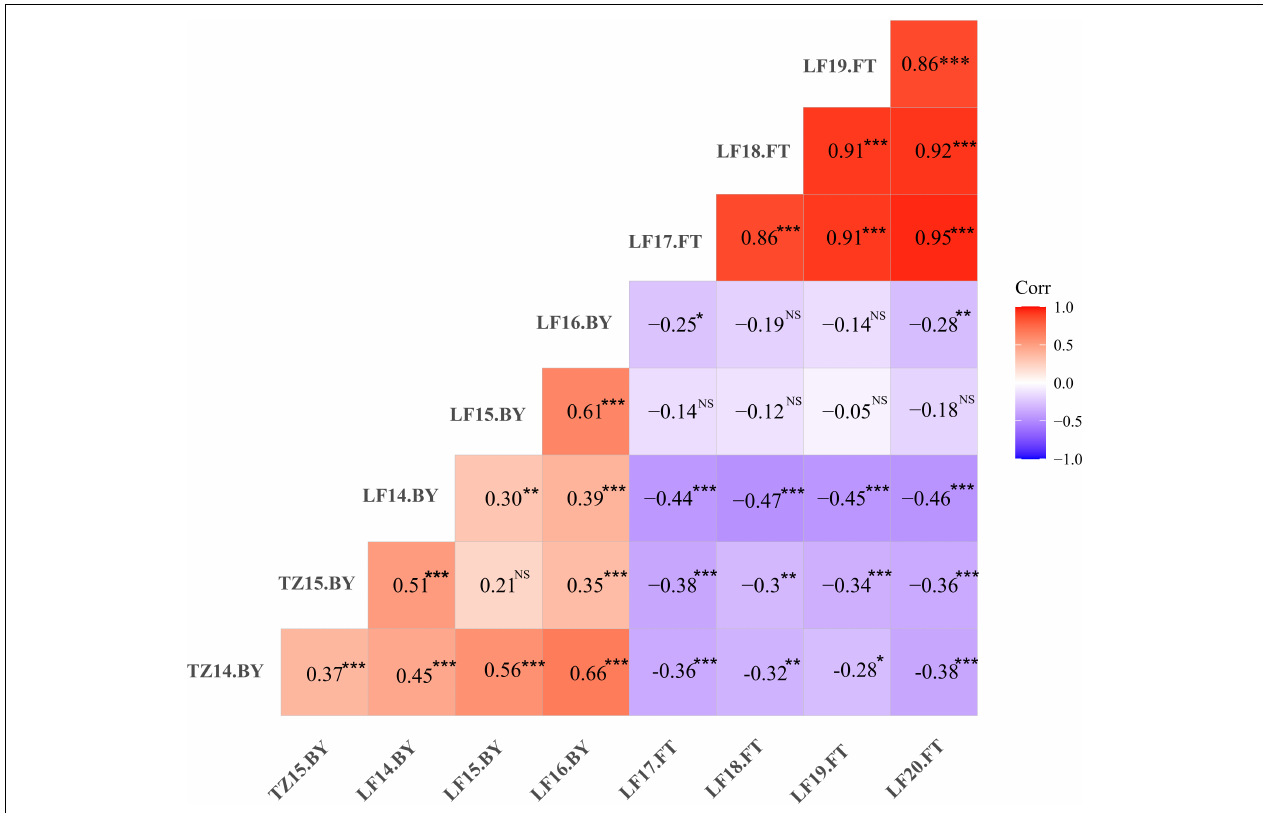
FIGURE 2 | Phenotypic correlations of flowering time (FT) and biomass yield (BY) among different environments in the F 1 population. Red and blue colors represent positive and negative correlations ( r ) between traits, respectively. TZ; Tongzhou; LF, Langfang, e.g., TZ14.BY indicates biomass yield data collected at Tongzhou in 2014. * P < 0.05, ** P < 0.01, *** P < 0.001, NS, non-significant. The results of yield were published in our previous study Zhang et al. (2019).